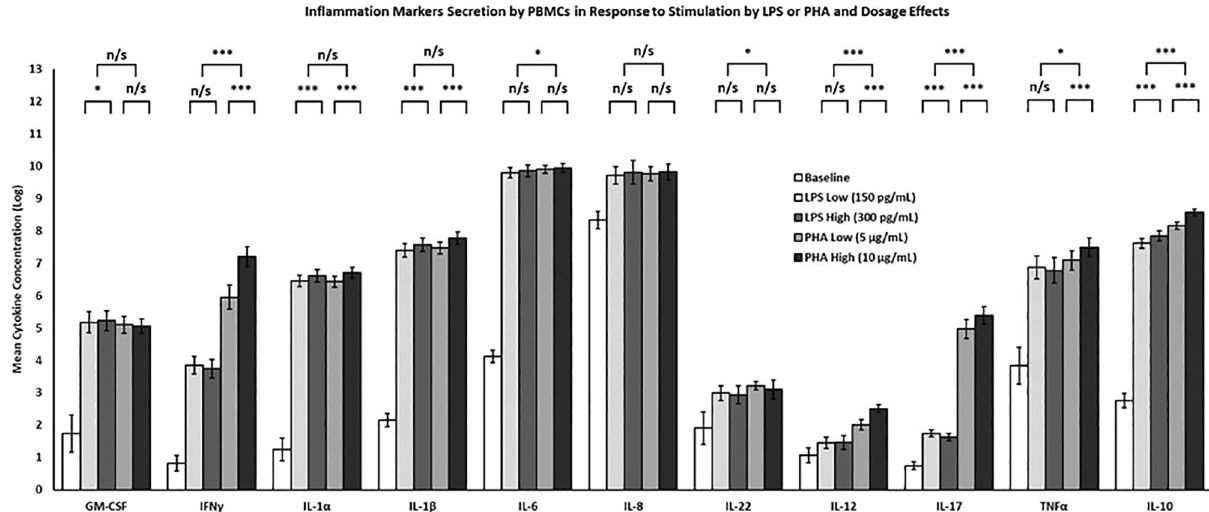
Figure 2. Differences in levels of inflammatory cytokines secreted from PBMCs in response to stimulation with either LPS or PHA and effects of IA dosage. Statistically significant differences are indicated for mean concentration values (+/− SEM) obtained for each marker under LPS or PHA stimulation, as well as differences between the low and high doses within the applied IA. Baseline secretion from PBMCs for each of the markers was significantly different ( p < 0.001) than the mean concentration secreted in response to either IA. Legend: n/s—no significant difference; *—significant difference, p < 0.05; ***—significant difference, p <